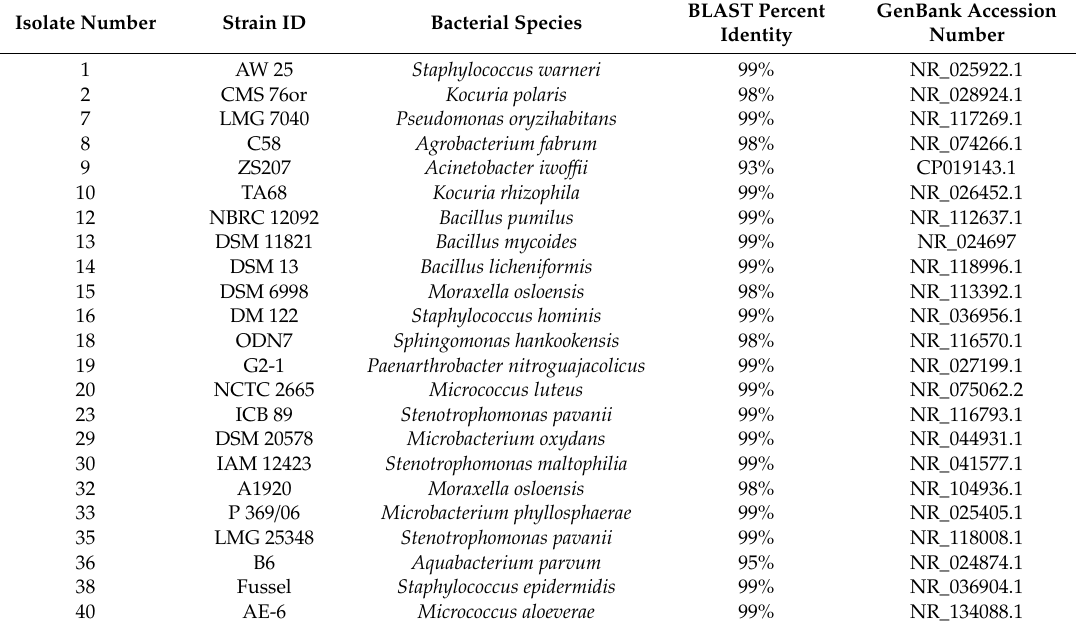
Table 5. List of isolated-cultivable bacteria derived from washing the sampled filters. The basic local alignment search tool (BLAST) percent identity expresses how similar the query sequence (rDNA16S) of each isolate was to the target sequence that was present in the